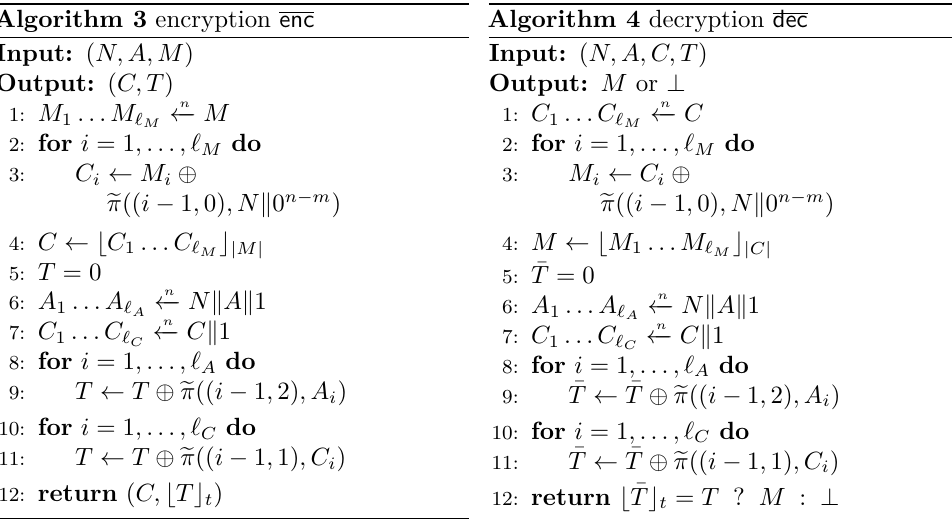
Algorithm 3 encryption enc Algorithm 4 decryption